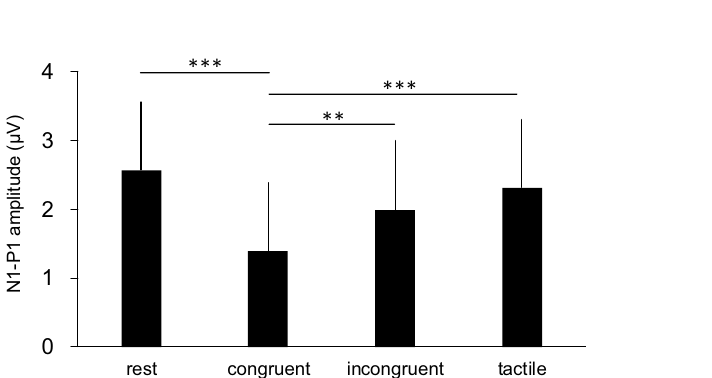
Figure 1. Grand averaged waveforms of somatosensory evoked potentials (SEPs) during all conditions in Experiment 1. The first negative peak approximately 20 ms after electrical stimulation (N1) and subsequent positive peak at about 25 ms (P1) were clearly identified in all conditions.